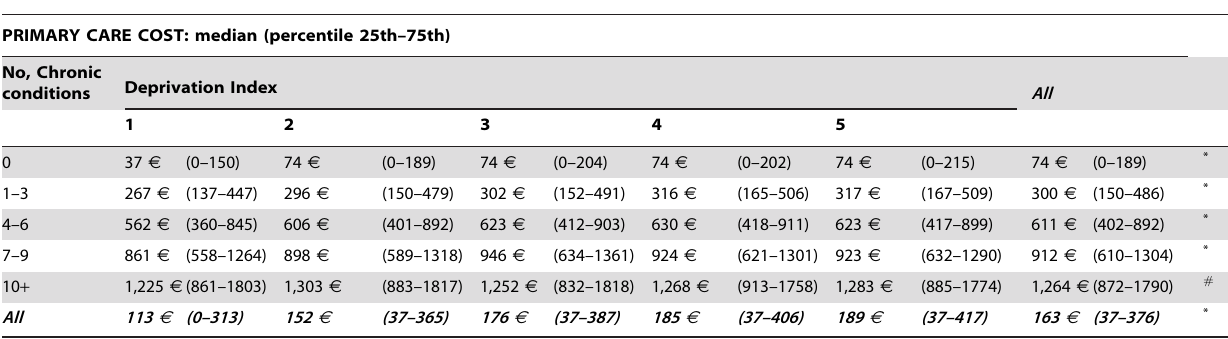
Table 3. Comparison of medians of annual primary care costs per patient, depending on number of chronic diseases and deprivation index.